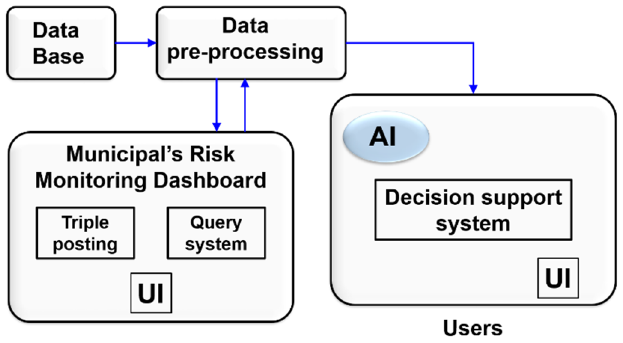
Figure 2. Merged Model.